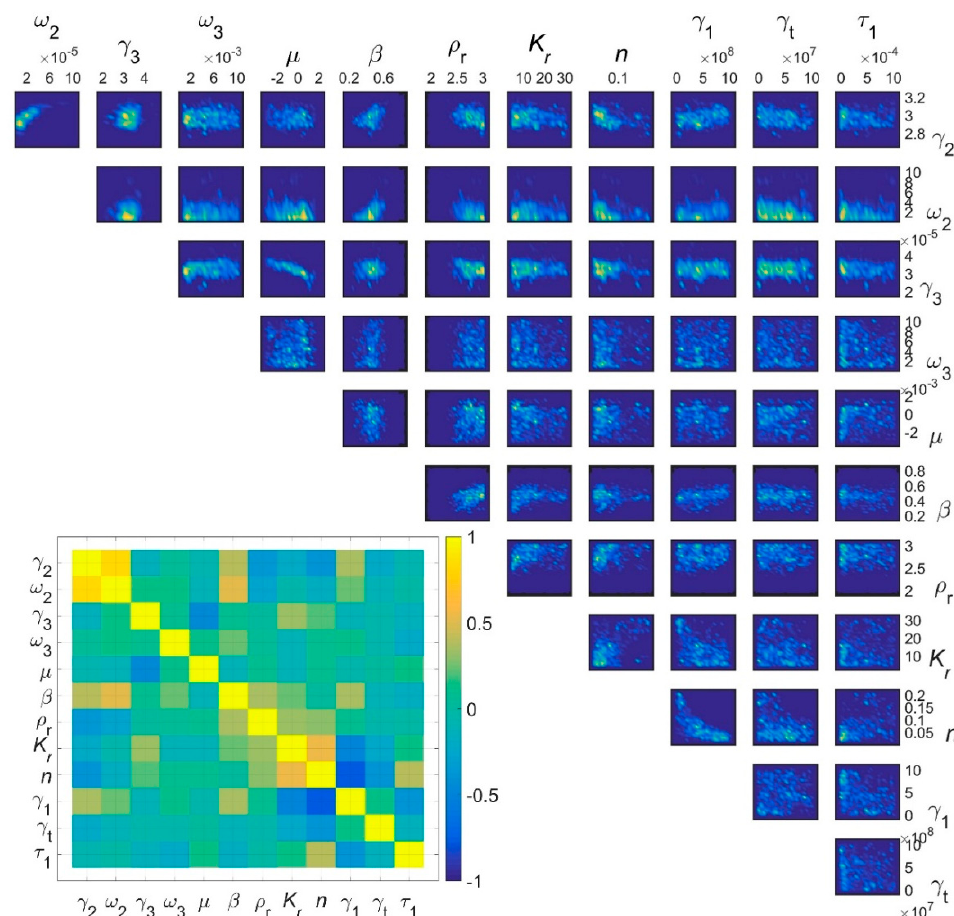
Figure 7. Estimates of two-dimensional marginal PPDs for grain-shearing elastic model parameters ( top right ) and correlation matrix map ( bottom left